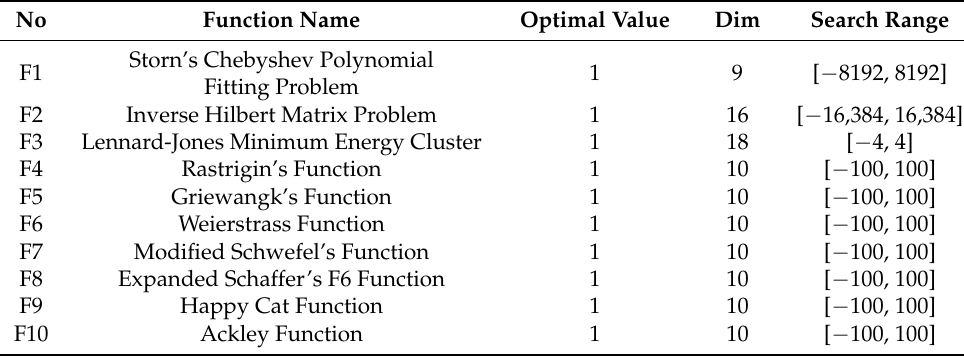
Table 1. The details of the CEC2019 test